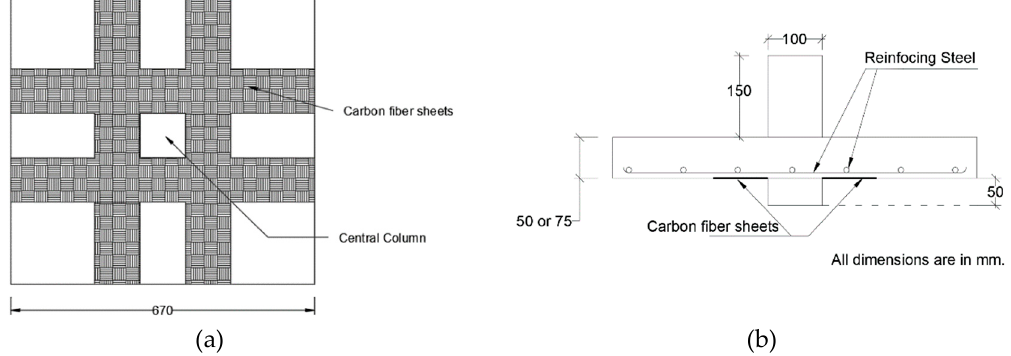
B Figure 1. Carbon fiber reinforced polymer (CFRP) pattern A with diagonal strips provide higher two- way shear capacity compared to pattern B with orthogonal strips [25]. Applying CFRP vertically in the form of shear reinforcement is superior to bonding CFRP strips/laminate on the tension side in terms of enhancing punching shear strength. Sissakis and Sheikh [26] reported 80% increases in punching shear capacity by applying CFRP strips vertically through holes created at constant spacing perpendicular to the loading column in a manner similar to stitching of the slab. Harajli and Soudki [27] demonstrated that providing reinforcing CFRP strips on the tension face of the slab increased the punching shear strength ranged from 17% to 45% compared to the control flat slab specimens that did not contain CFRP strips for strengthening purpose as seen in Figure 2. The mechanism by which this method of strengthening increases two-way shear strength is by restricting the growth of tension cracks or by increasing flexural strength at the connection. Therefore, strengthening the slab on the tension slide in the column zone may change flexural failure mode to